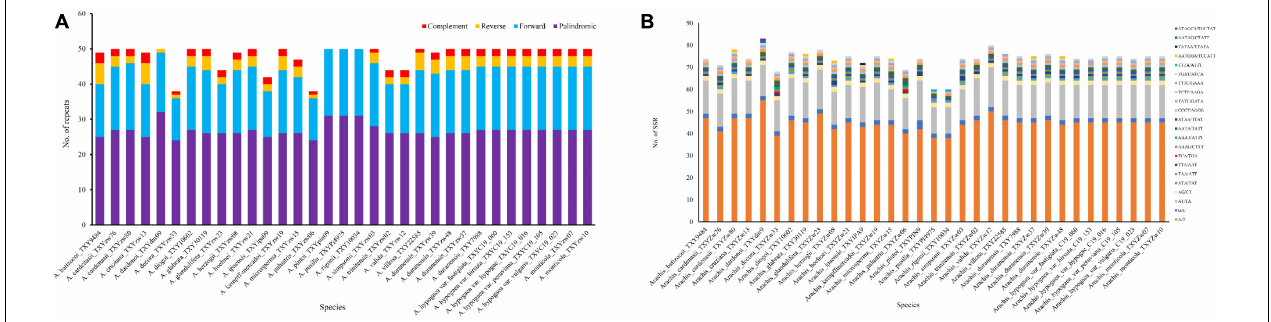
FIGURE 2 | Analyses of repeated sequences in the plastomes of the 33 Arachis accessions. (A) Numbers of repeats and their types; (B) number of identified SSRs motifs and their